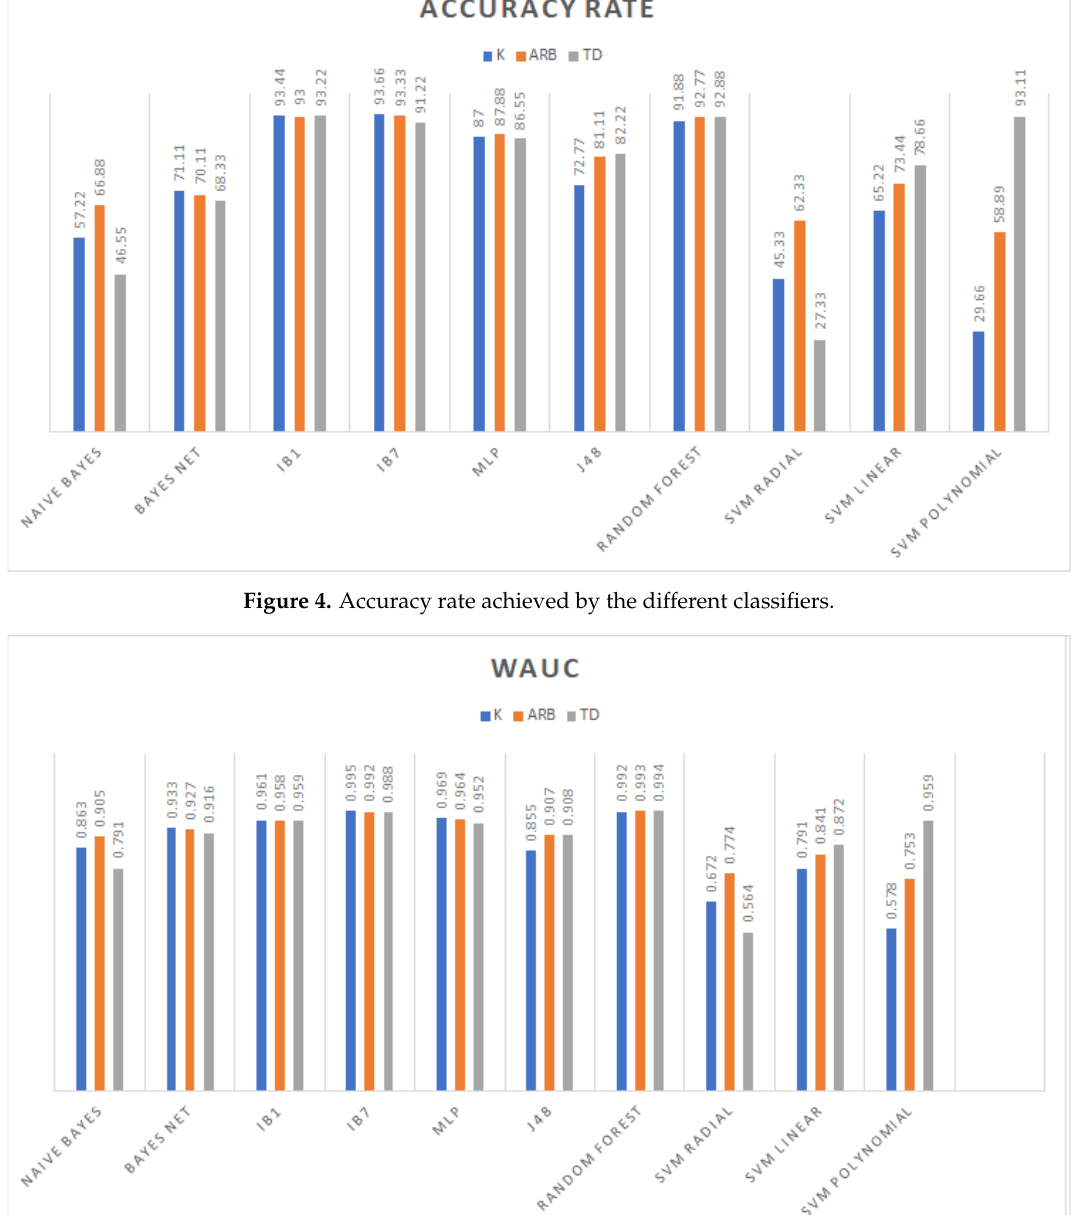
Figure 5. WAUC achieved by the different